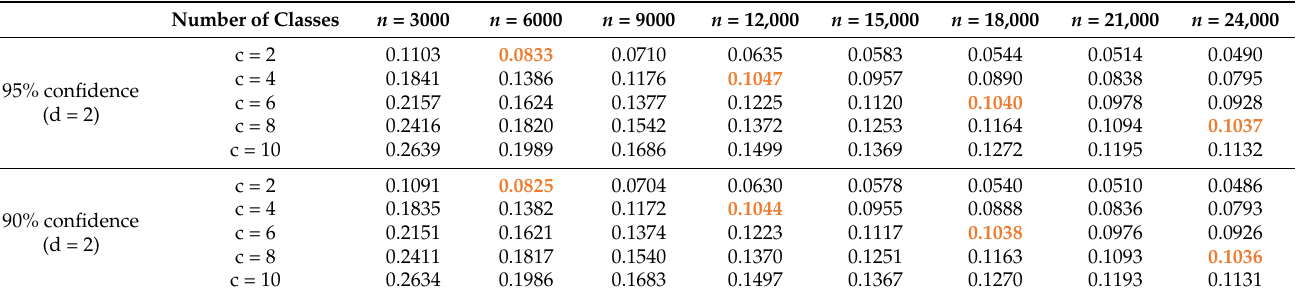
Table 2. The relationship between EXP and sample size.